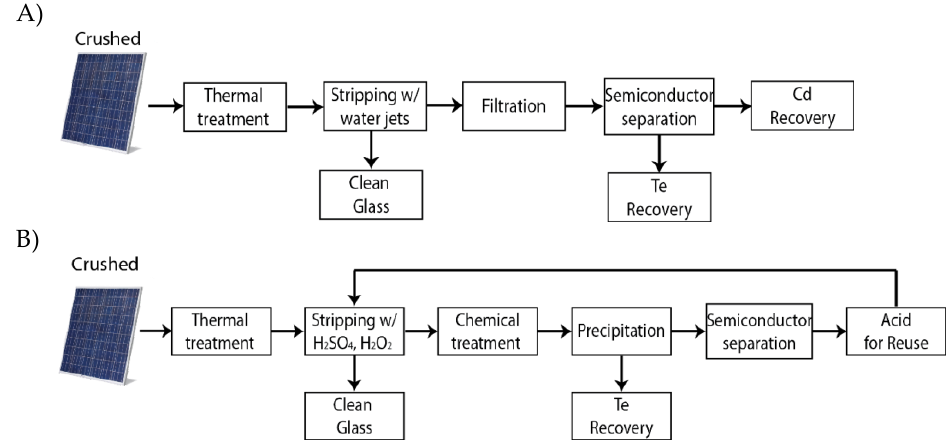
Figure 4. Recycling of CdTe thin-film PV module flow chart using ( A ) water jets, ( B ) chemical stripping .